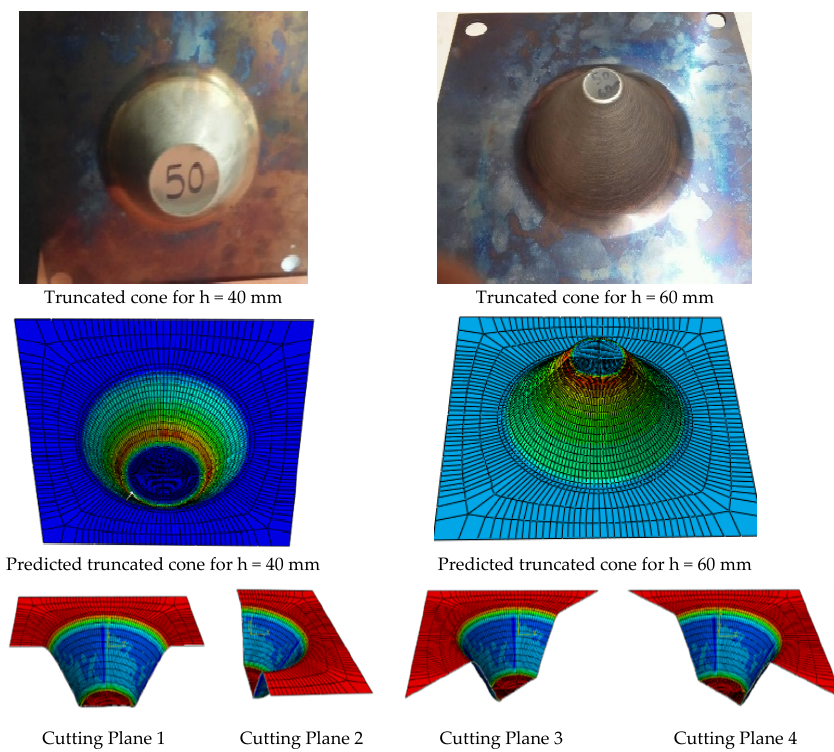
Figure 12. Four cutting planes measurement of FE simulation truncated cone .